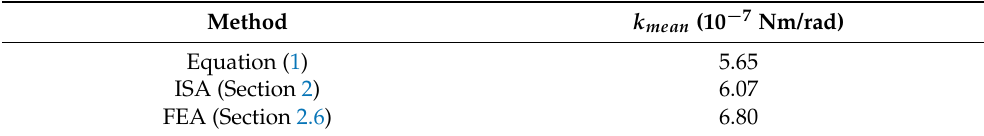
Table 4. Average flexure element stiffness obtained by means of different methods. (ISA = Inverse Static